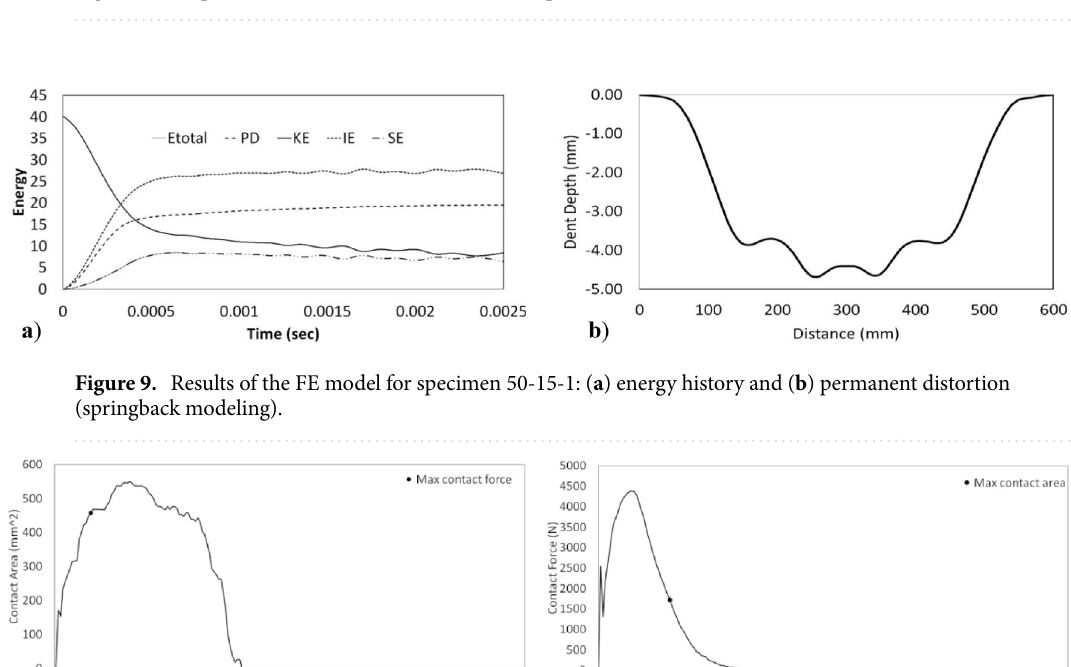
Figure 8. Displacement results of the FE model for specimen 50-15-1.